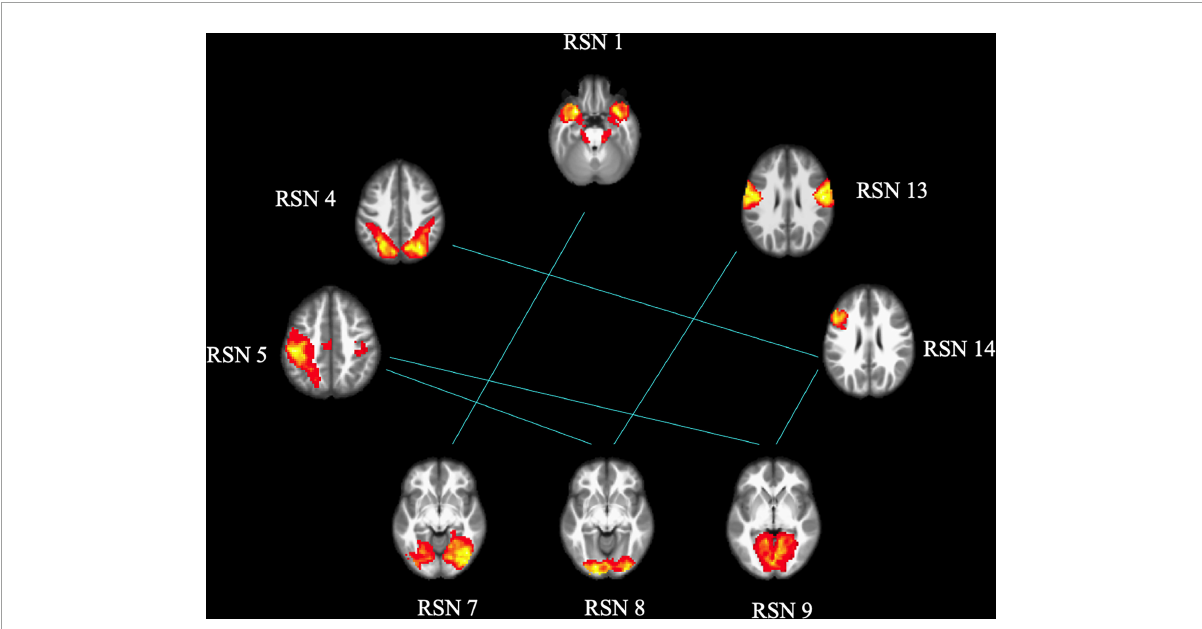
FIGURE3 FCon-related differences in brain functional network connectivity between RSNs. The blue line between relative RSNs means significantly lower connectivity strength in FCon patients. FCon, functional constipation; RSN, resting-state